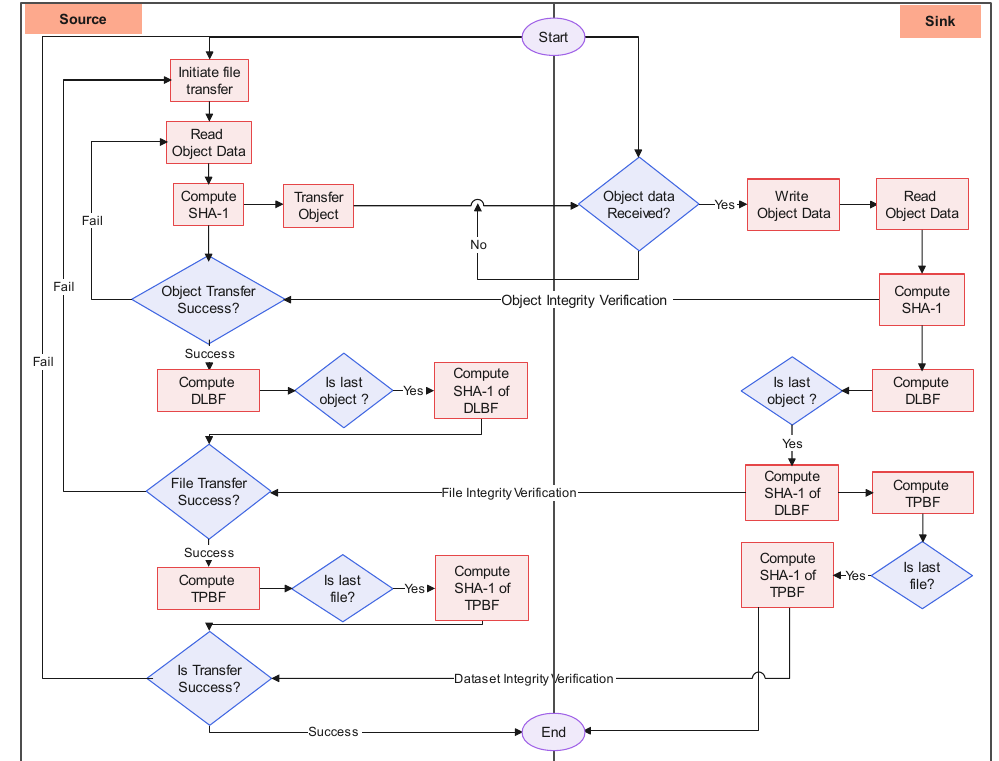
Figure 6. Flow chart of two-phase Bloom-filter-based end-to-end data integrity